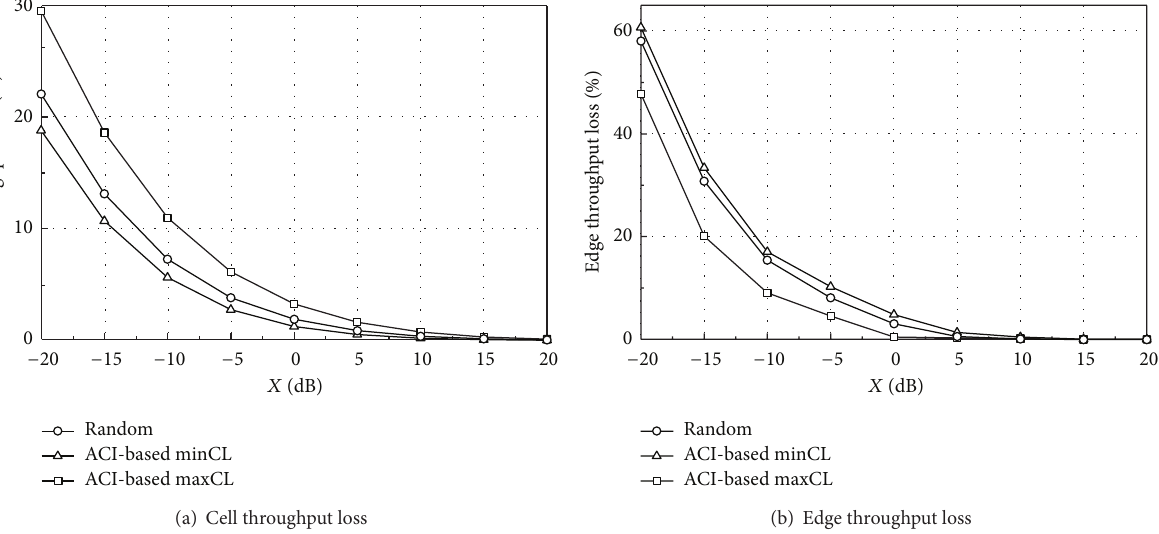
Figure 8: Throughput loss (TPC set 1,